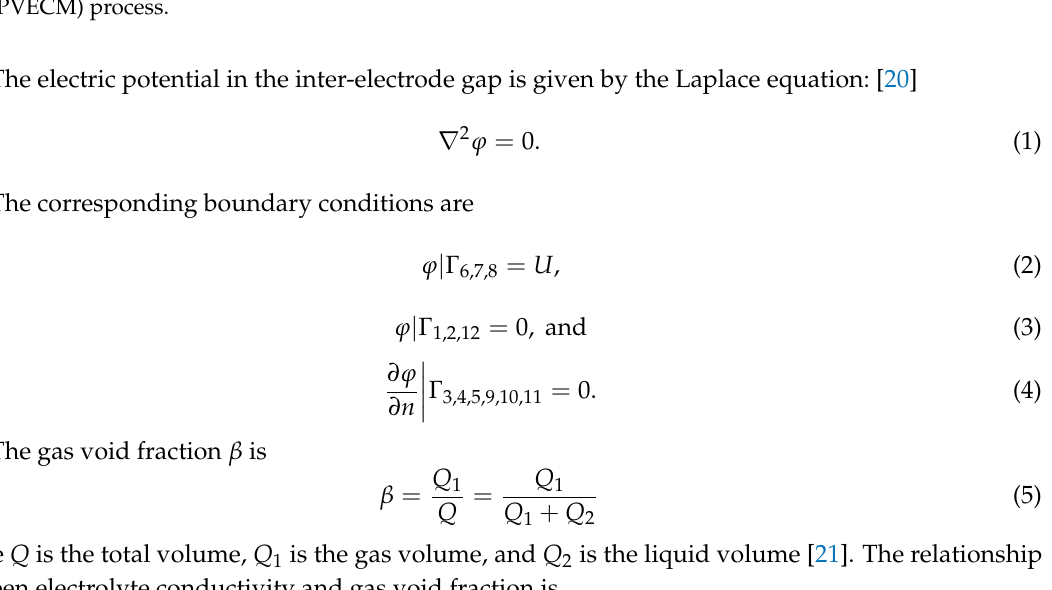
Figure 2. Schematic diagram of the pulse duration and tool vibration in electrochemical machining (PVECM) process.